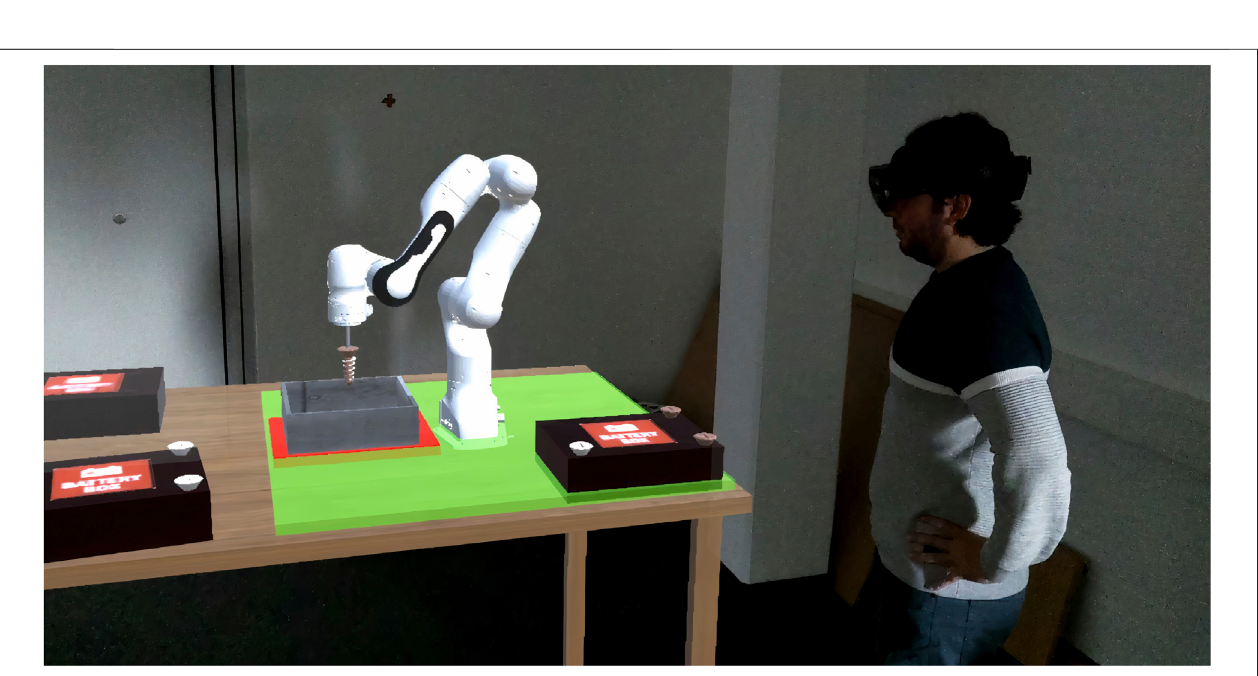
FIGURE 2 | Third party point of view. A participant wears the HoloLens and commands the robot to loosen screws. It is allowed to locate the battery anywhere inside the green workspace except over the screw bin which is marked in red.